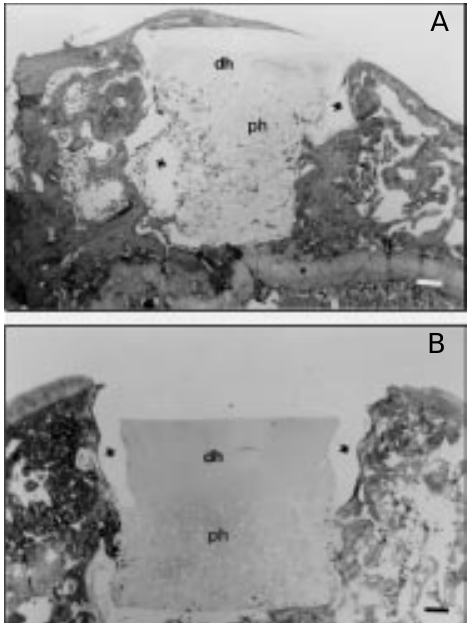
Figure 4 - Section of the defect repaired with the hydrogel im- plant stained by Masson’s tri- chrome (A) 8 weeks after opera- tion and (B) 16 weeks after op- eration. The dense hydrogel (dh) top surface and the porous hy- drogel (ph) substrate filling the defect can be seen. The implant seems to be well anchored to the surrounding tissues. * = Ex- perimental artifact caused by hy- drogel shrinkage during the de- hydration of the section. Magni- fication bar = 200